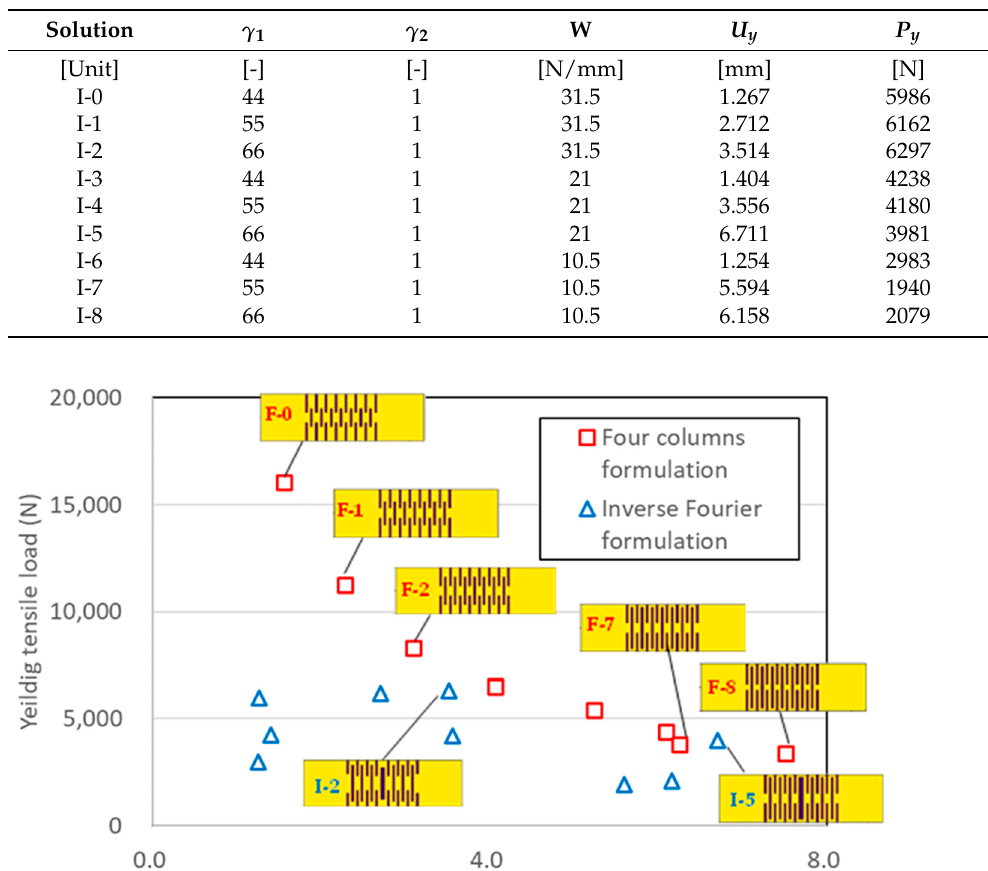
Table 2. Single optimum solutions by strain energy maximization using inverse Fourier formulation